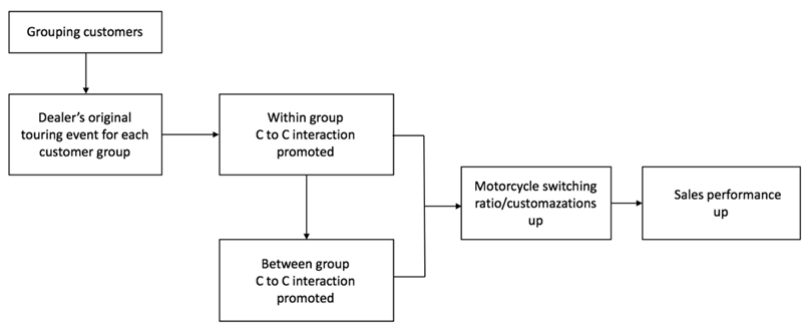
Figure 1. C to C interaction effect and sales performance of Dealer